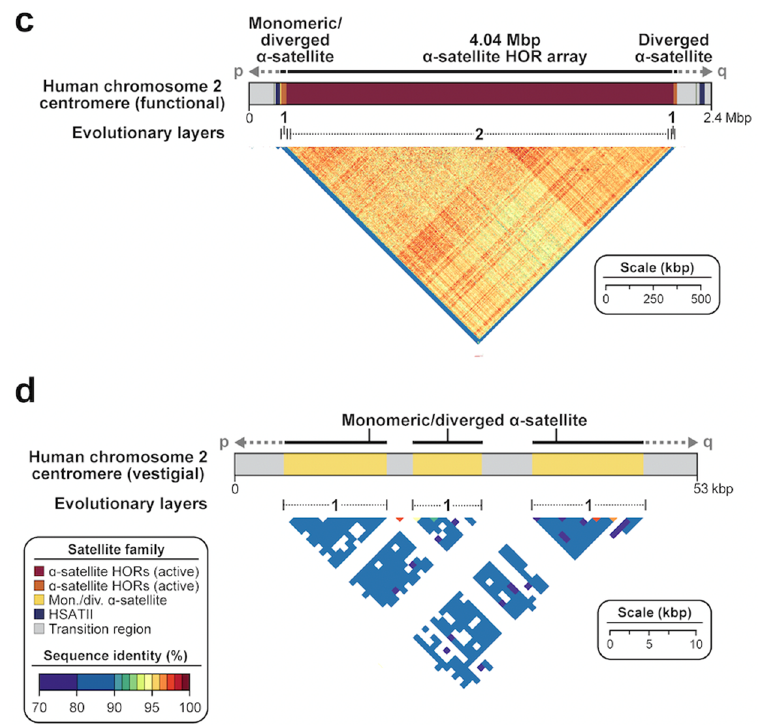
Figure 6. Evolution of centromeric satellite regions. ( a ) Dot matrix plot showing pairwise sequence identity between human (CHM13) and chimpanzee chromosome 8 centromeric regions. While there is >95% sequence identity in the monomeric α -satellite sequences and 70–80% sequence identity in the transition regions between monomeric α -satellite and α -satellite HORs, there is almost no sequence identity shared between sequences in the α -satellite HOR array. Despite being similar in size, the two apes show nearly complete turnover of their α -satellite HORs, with best matches occurring at the periphery (horizontal lines). ( b ) StainedGlass view [56] showing the organization and pairwise sequence identity among 5 kbp segments across an orangutan orthologous chromosome 8 centromere. Orangutan α -satellite HOR arrays are composed of mosaic blocks of α -satellite HORs with <95% sequence identity shared between them. Adapted from [42]. ( c , d ) StainedGlass view [56] showing the organization and pairwise sequence identity among 5 kbp segments across ( c ) the functional human (CHM13) chromosome 2 centromere and ( d ) the vestigial human (CHM13) chromosome 2 centromere. The vestigial centromere is a remnant of the chromosome 2B centromere present in chimpanzee. It is highly degraded and reduced in size with little obvious α -satellite HOR structure, owing to its